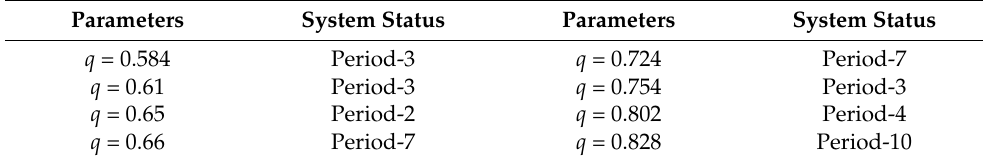
Figure 4. Attractor trajectories with β 1 = 0.4, β 2 = 12, ( a ) q = 0.4, ( b ) q = 0.66, ( c ) q = 0.8. Table 1. Different orders, the periodic states of the FOHNN system.